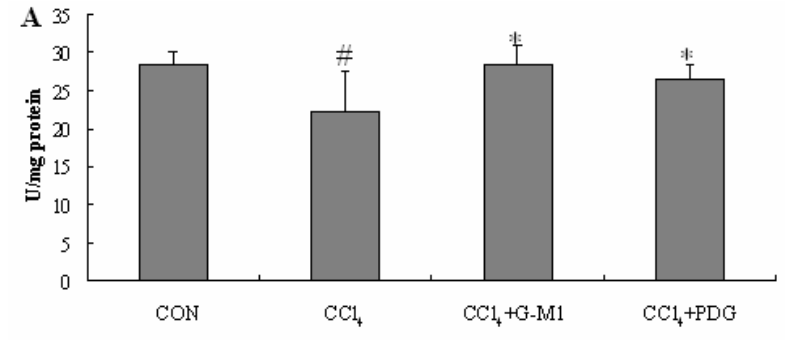
Figure 5. Effect of PDG and G-M1 on antioxidant enzyme (SOD) activities ( A ) and hepatic MDA level ( B ) in CCl -induced liver injury in mice. PDG and G-M1 were 4 administered for a period of 4 weeks at dose of 300 mg/kg and 30 mg/kg, respectively. group. # Significance P < 0.05, compared * Significance P < 0.05, compared with CCl 4 with normal control